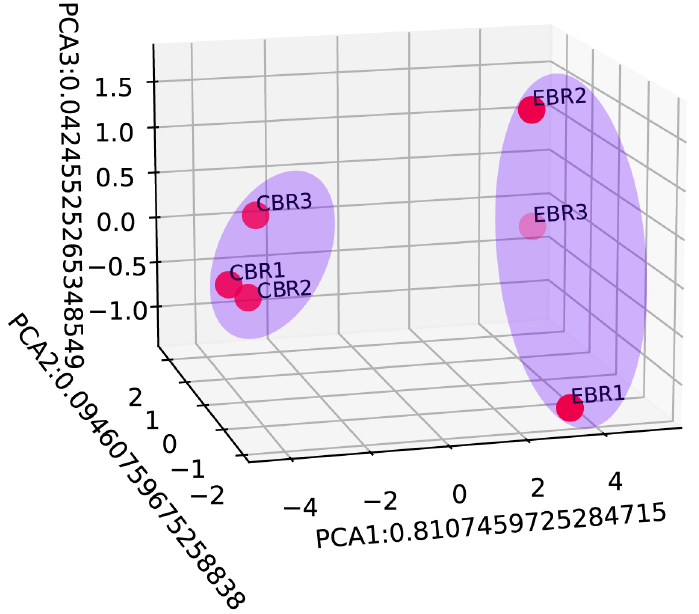
Figure 5. Principal component analysis (PCA) based on the normalized expression data of differentially expressed genes. All 6 samples were shaded by different light blue ellipses indicating the different treatment groups.